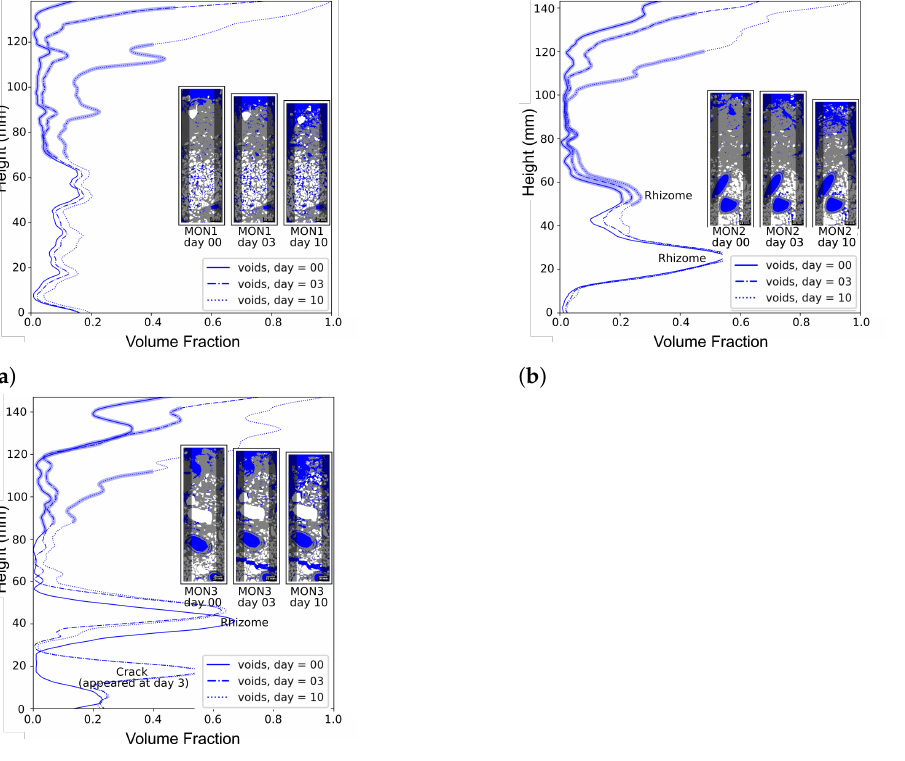
Figure 5. Evolution of the void phase volume fraction profiles. The deposit layer is represented by a wider trace in the curves. Computations were performed for a region of interest (ROI) of 60%. ( a ) MON1, ( b ) MON2, ( c )